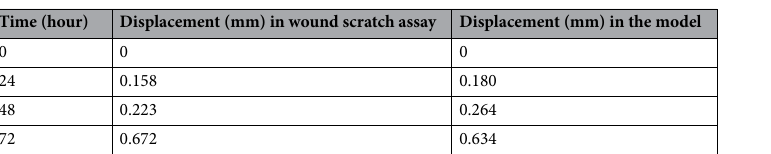
Table 4. Average displacement of cancer cells in wound scratch assay versus model